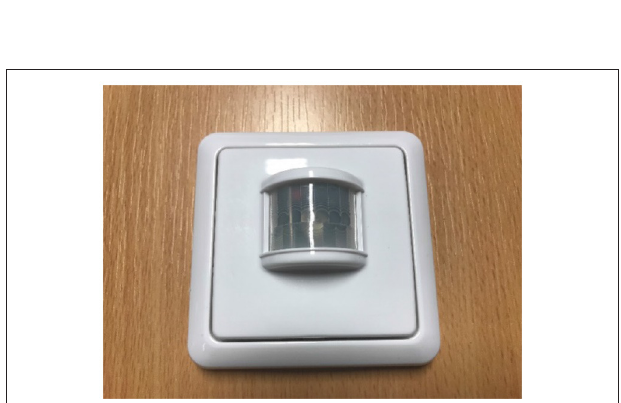
FIGURE 5 | PIR sensor attached to a wood surface.